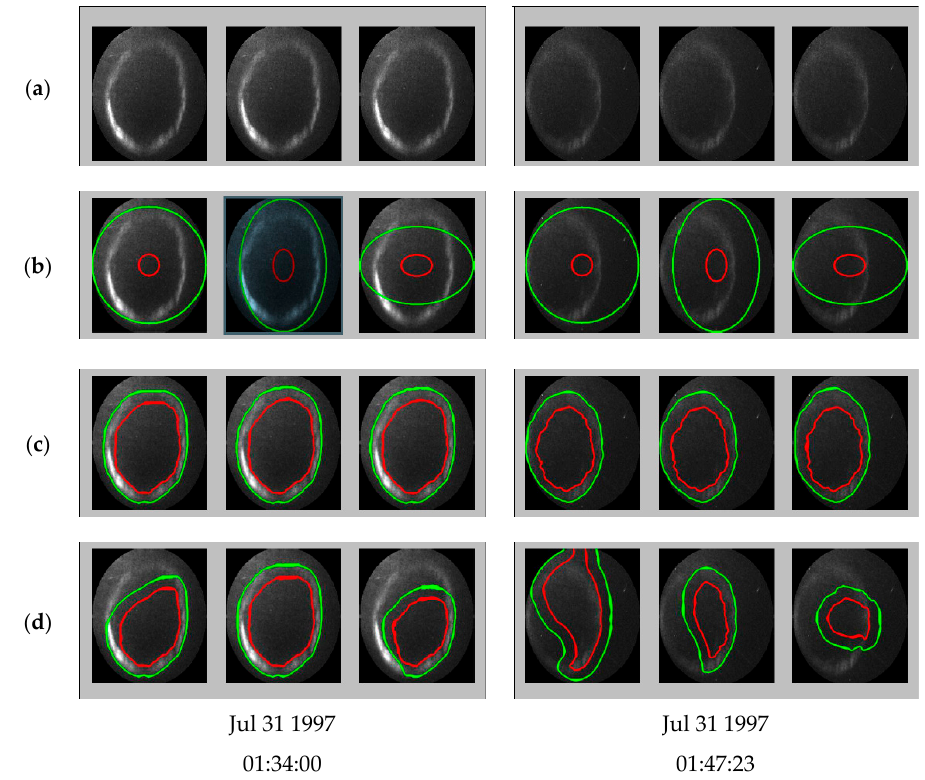
Figure 10. The segmentation results of LIDLSM and the deep feature-based adaptive level set (DFALS) model initialized by several different level set curves. ( a ) The UVI images captured by Polar satellite on Jul 31 1997 01:34:00 and Jul 31 1997 01:47:23. ( b ) The initial level set curves. ( c ) Segmentation results of the DFALS. ( d ) Segmentation results of the LIDLSM.